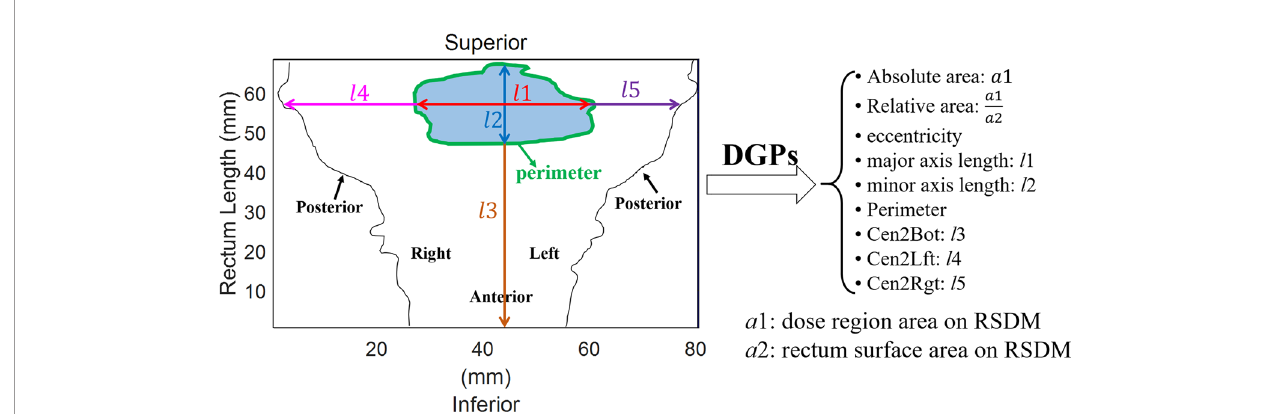
FIGURE 3 | DGPs extracted from the